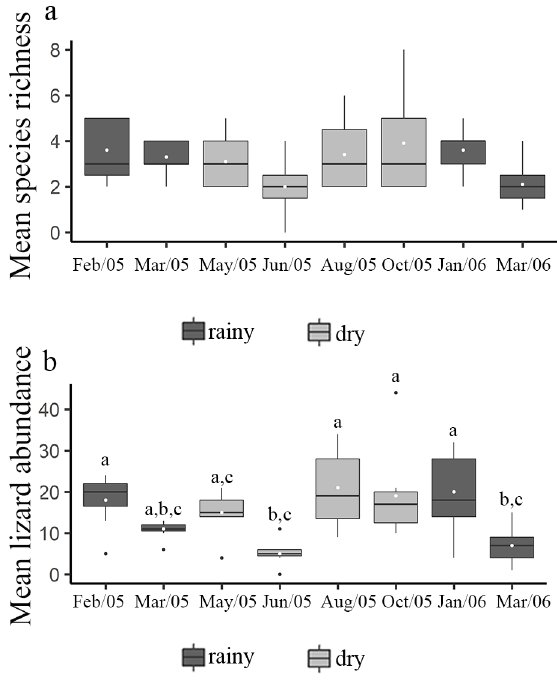
Figure 2. Variation of: (a) species richness; (b) lizard abundance in the Nhumirim Ranch, Pantanal, Brazil, from 2005 to 2006. * represent mean values. Different letters mean statistically significant differences.